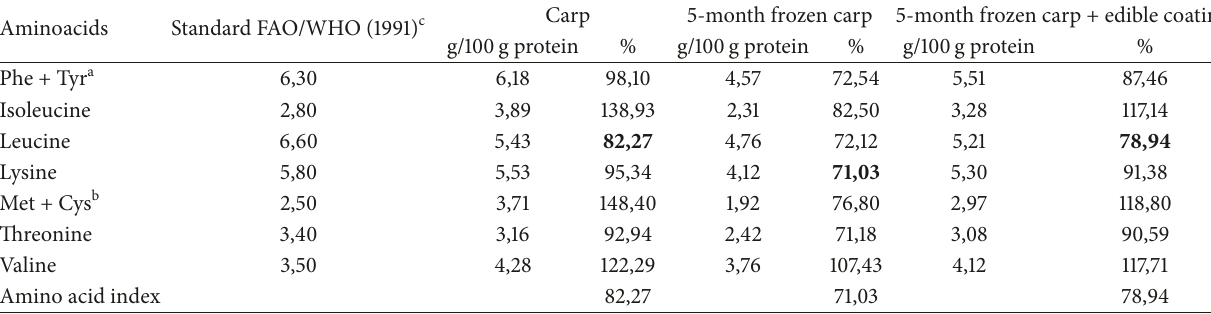
Figure 4: SDS-PAGE of common carp fillets stored at − 18 ∘ C; control batch (C) fillet without coating and filleted carp with edible coating (C + EC); M1, M2, M4, and M5 from first to fifth month during storage. Table 2: Values of the limiting aminoacid index